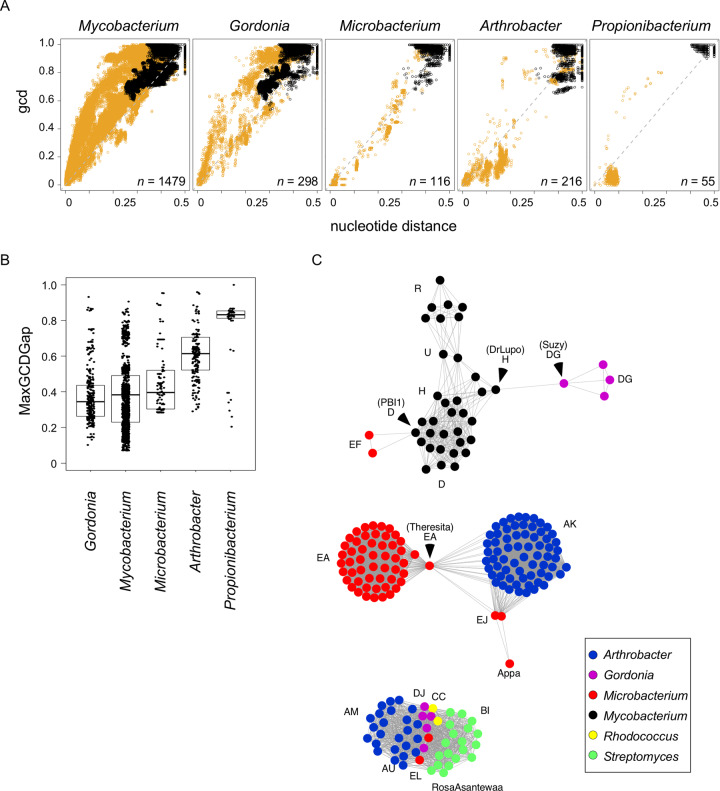
Comparison of phage genomic diversity by host genera.A. Genomic similarity plot comparing gene content dissimilarity (gcd) to whole genome nucleotide distance, as previously reported [49]. Each data point reflects a genome comparison involving one phage that infects the indicated host genus and (orange) a second phage that infects the indicated host genus or (black) one phage that infects a different host genus. n = number of phages that infect the indicated host genus. B. Box plot comparing the MaxGCDGap of phages from different host genera. Each data point is a phage genome, the box depicts the middle 50% of data, and the black bar represents the median. Number of phages per host genus as in panel A. C. Three representative genome networks highlight genomic relationships of Microbacterium phages to phages of other host genera. Each node represents a phage genome and is colored according to host genus. Edges between nodes represent pairs of phages that exhibit ‘intra-cluster’ genomic similarities (as measured by gene content dissimilarity and nucleotide distance from panel A). Selected phage names or cluster designations are highlighted for reference.